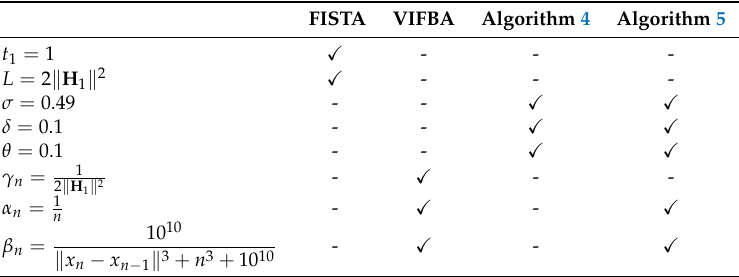
Table 4. Chosen parameters of each